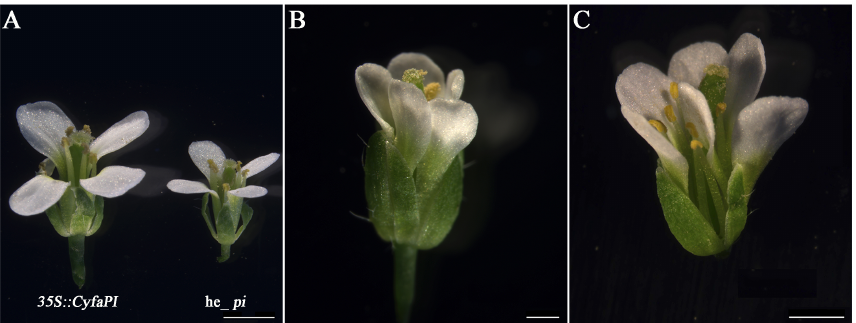
Figure 6. Interesting flower phenotypes of 35S::CyfaPI transgenic PI / pi-1 Arabidopsis . ( A ) The large flower of 35S::CyfaPI transgenic PI / pi-1 Arabidopsis and the PI / pi-1 Arabidopsis flower (he_ pi ) with four sepals in whorl 1, four petals in whorls 2, six stamens in whorl 3 and a gynoecium in whorl 4; ( B ) 35S::CyfaPI transgenic PI / pi-1 Arabidopsis producing flower with five petals in whorl 2; ( C ) 35S::CyfaPI transgenic PI / pi-1 Arabidopsis producing flower with six petals in whorl 2. Bars: (A) 5 mm; (C) 1 mm; (B) 500 μm.